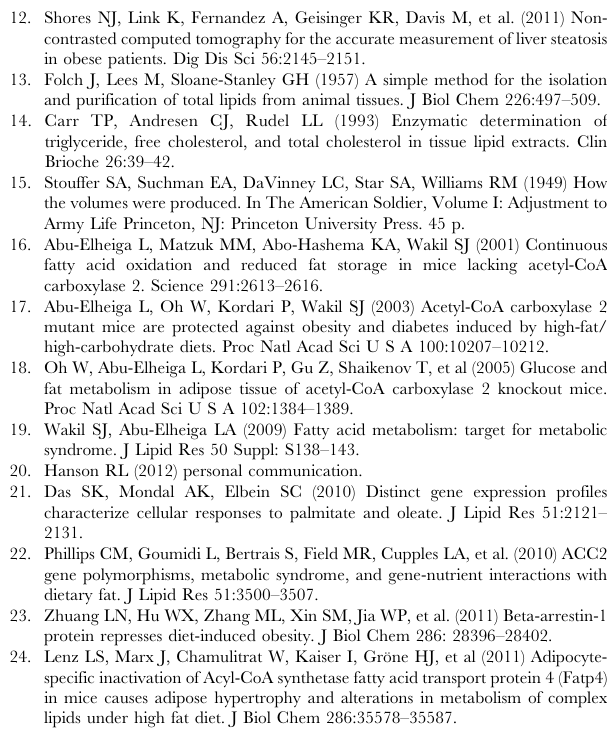
Figure S1 BMI vs. rs2268388 in Wake Forest diabetic men and women. S1-1. BMI vs. rs2268388 in Wake Forest diabetic African